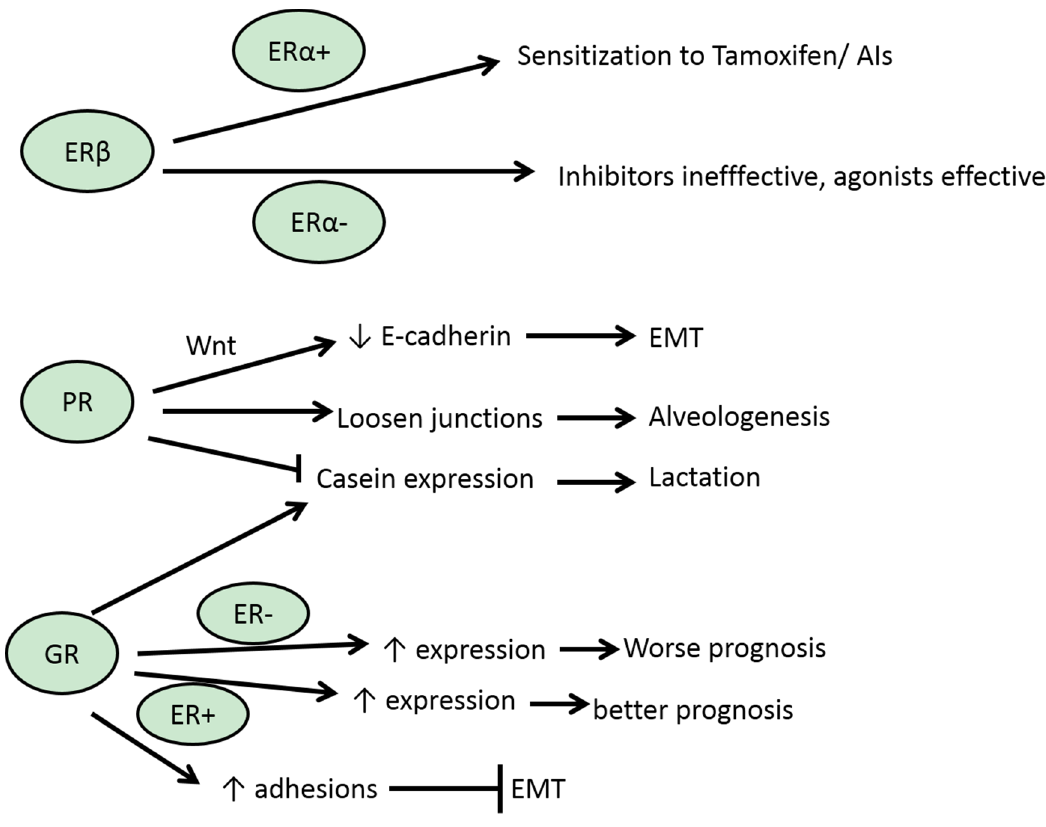
Figure 3. A schematic representation of selected EMT-related effects of ER β , PR and GR in normal breast development and breast cancer and relationships with ER α status.